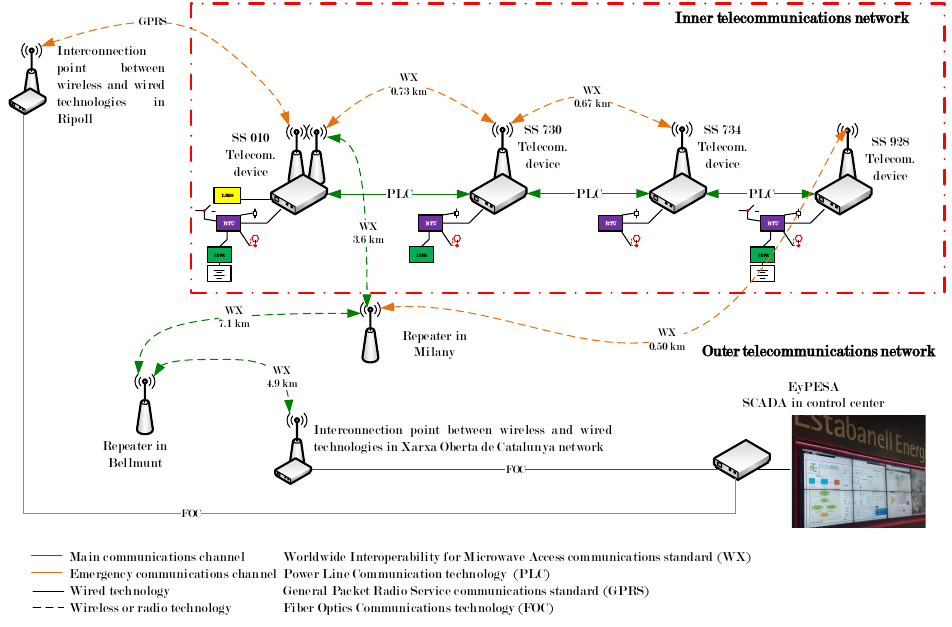
Figure 4. The telecommunications